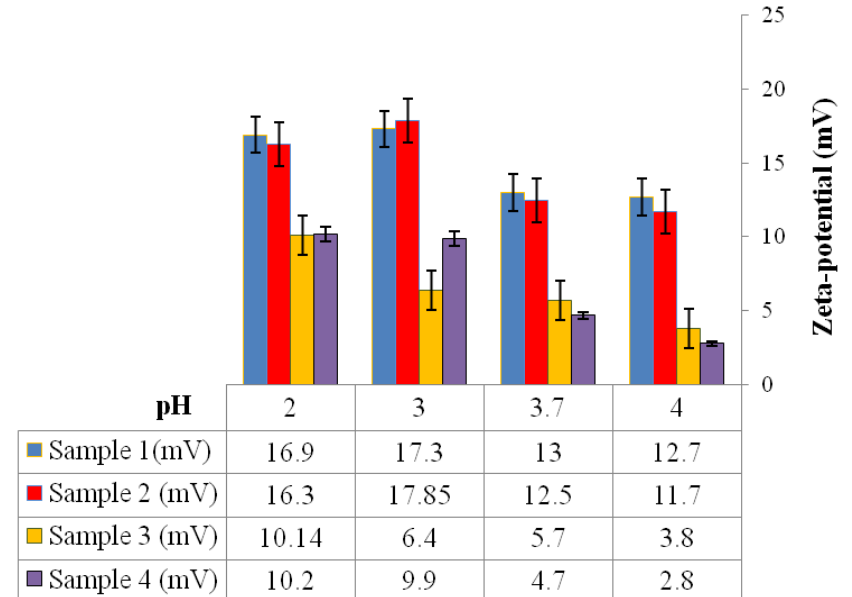
Figure 7. Zeta-potential values of P(3HB) microspheres fabricated using different conditions (Table 1) at different pH